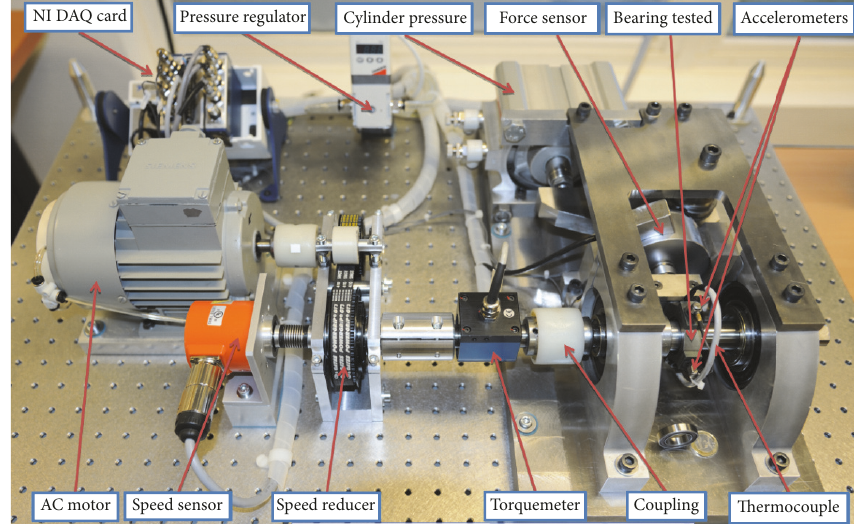
Figure 12: Overview of PRONOSTIA.